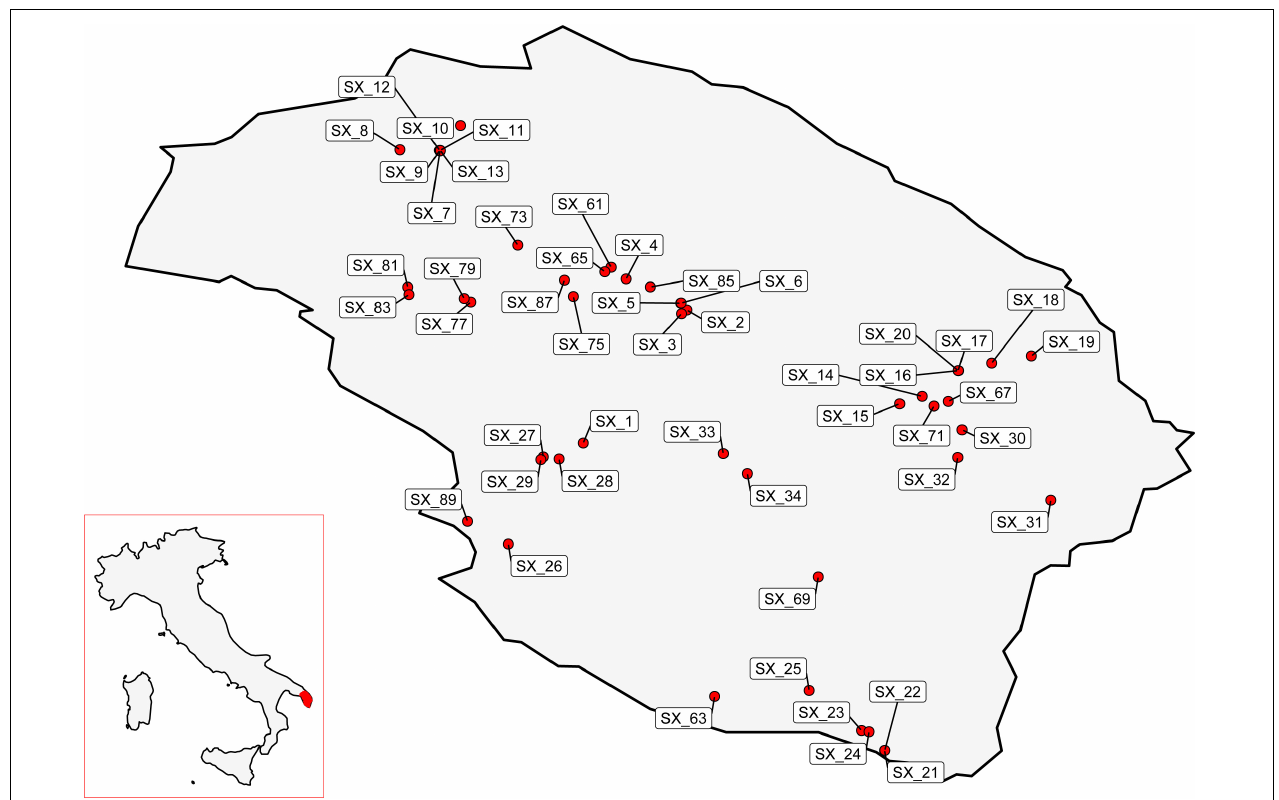
FIGURE 1 | Localization, in the province of Lecce, Salento, of the plants screened in this study.